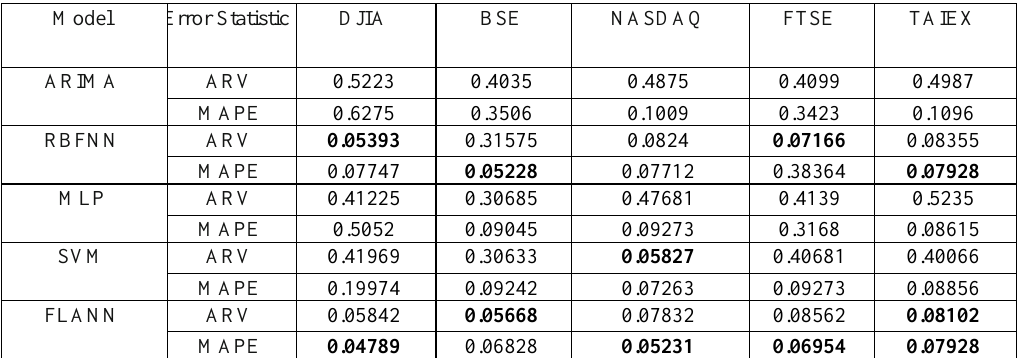
Table 3 . Performance of individual models on five data sets